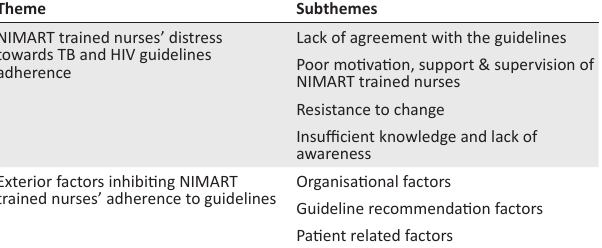
TABLE 2: Overall themes and subthemes that emerged from the data analysis. Theme Subthemes